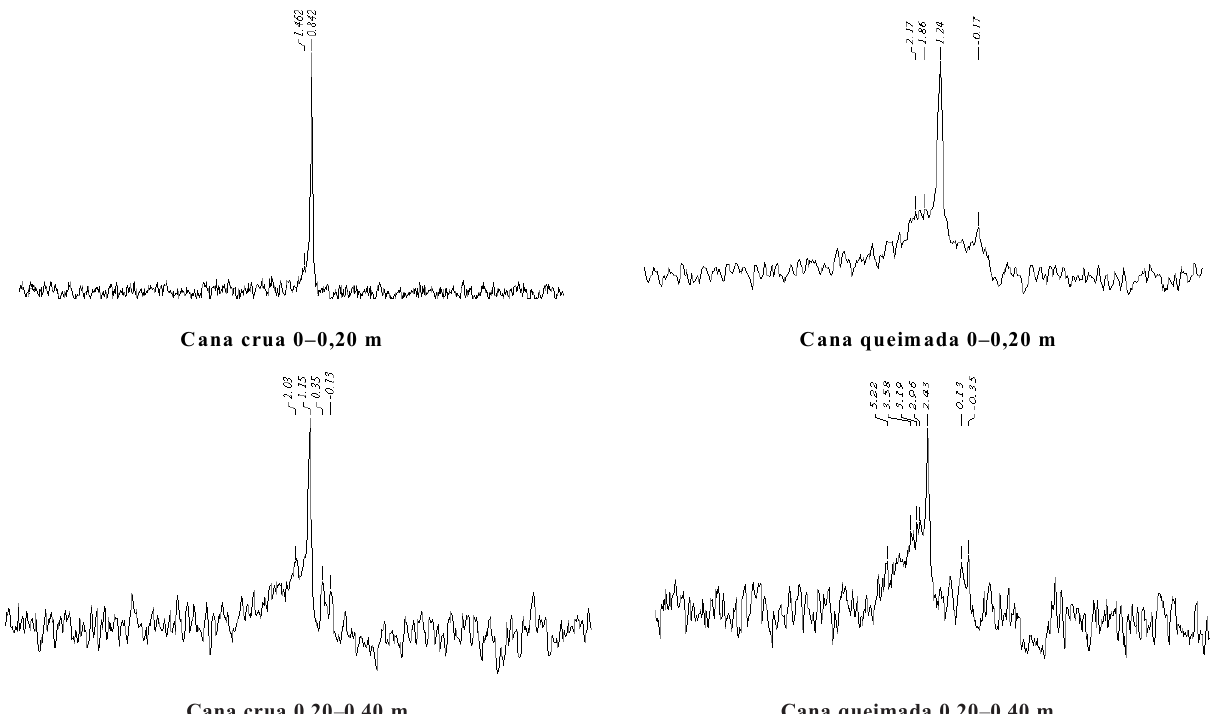
Cana crua 0,20 – 0,40 m Cana queimada 0,20 – 0,40 Figura 1. Espectros de RMN 31 P de ácidos húmicos extraídos de um Cambissolo Háplico Ta eutrófico vértico submetido aos manejos de cana crua e cana queimada.